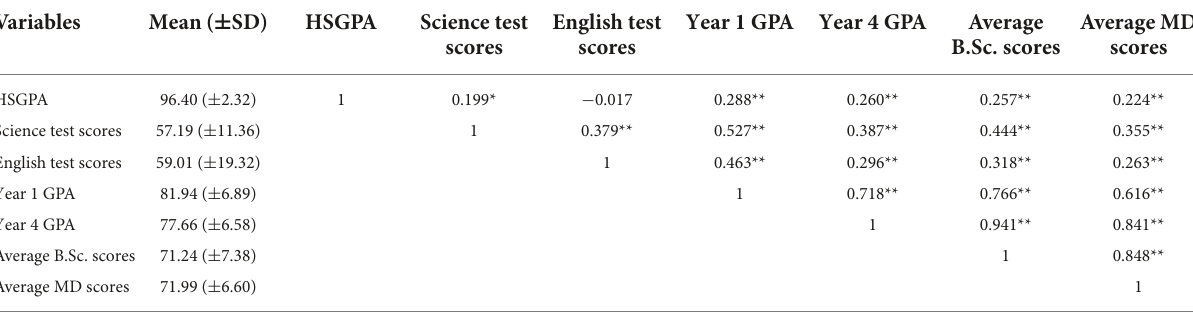
TABLE 2 Means, standard deviations, and correlation matrix of study